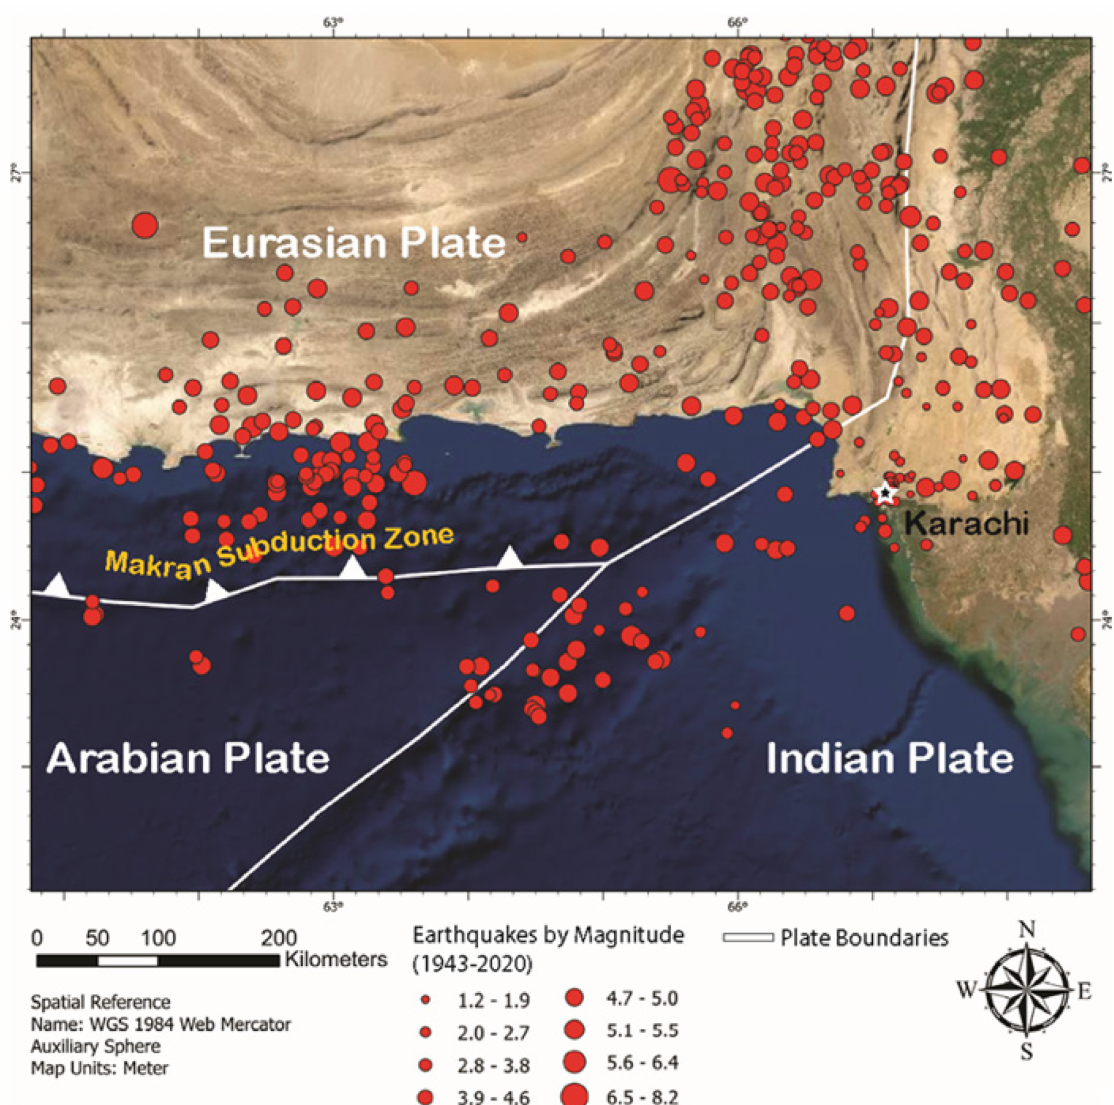
Figure 1. Simplified regional tectonic setting near Karachi showing historical seismicity with notable features highlighted. The location of Karachi is denoted with a star. (Source: Pakistan Meteorological Department, United States Geological